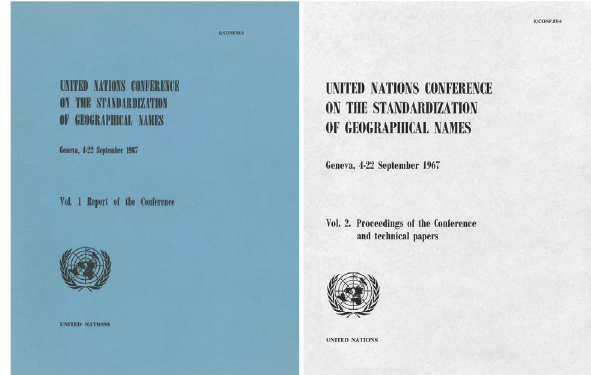
Fig. 2. Covers of the publications from the first United Nations Conference on the Standardization of Geographical Names – Report of the Conference (vol. 1) and Proceedings of the Conference and technical papers (vol.